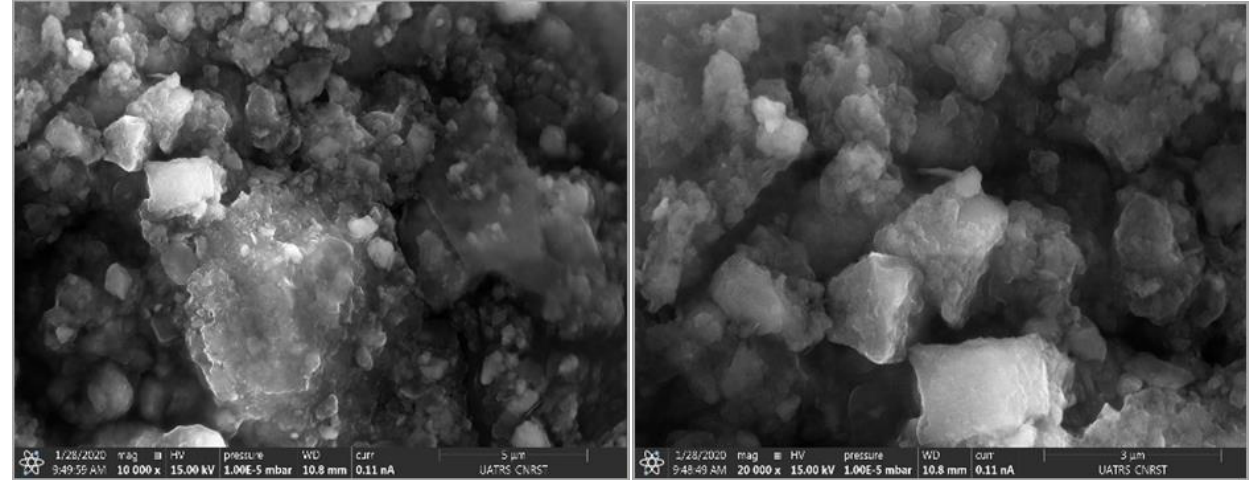
Figure 8. Scanning electron microscopy images of the HAp/HPMC composite (70/30).